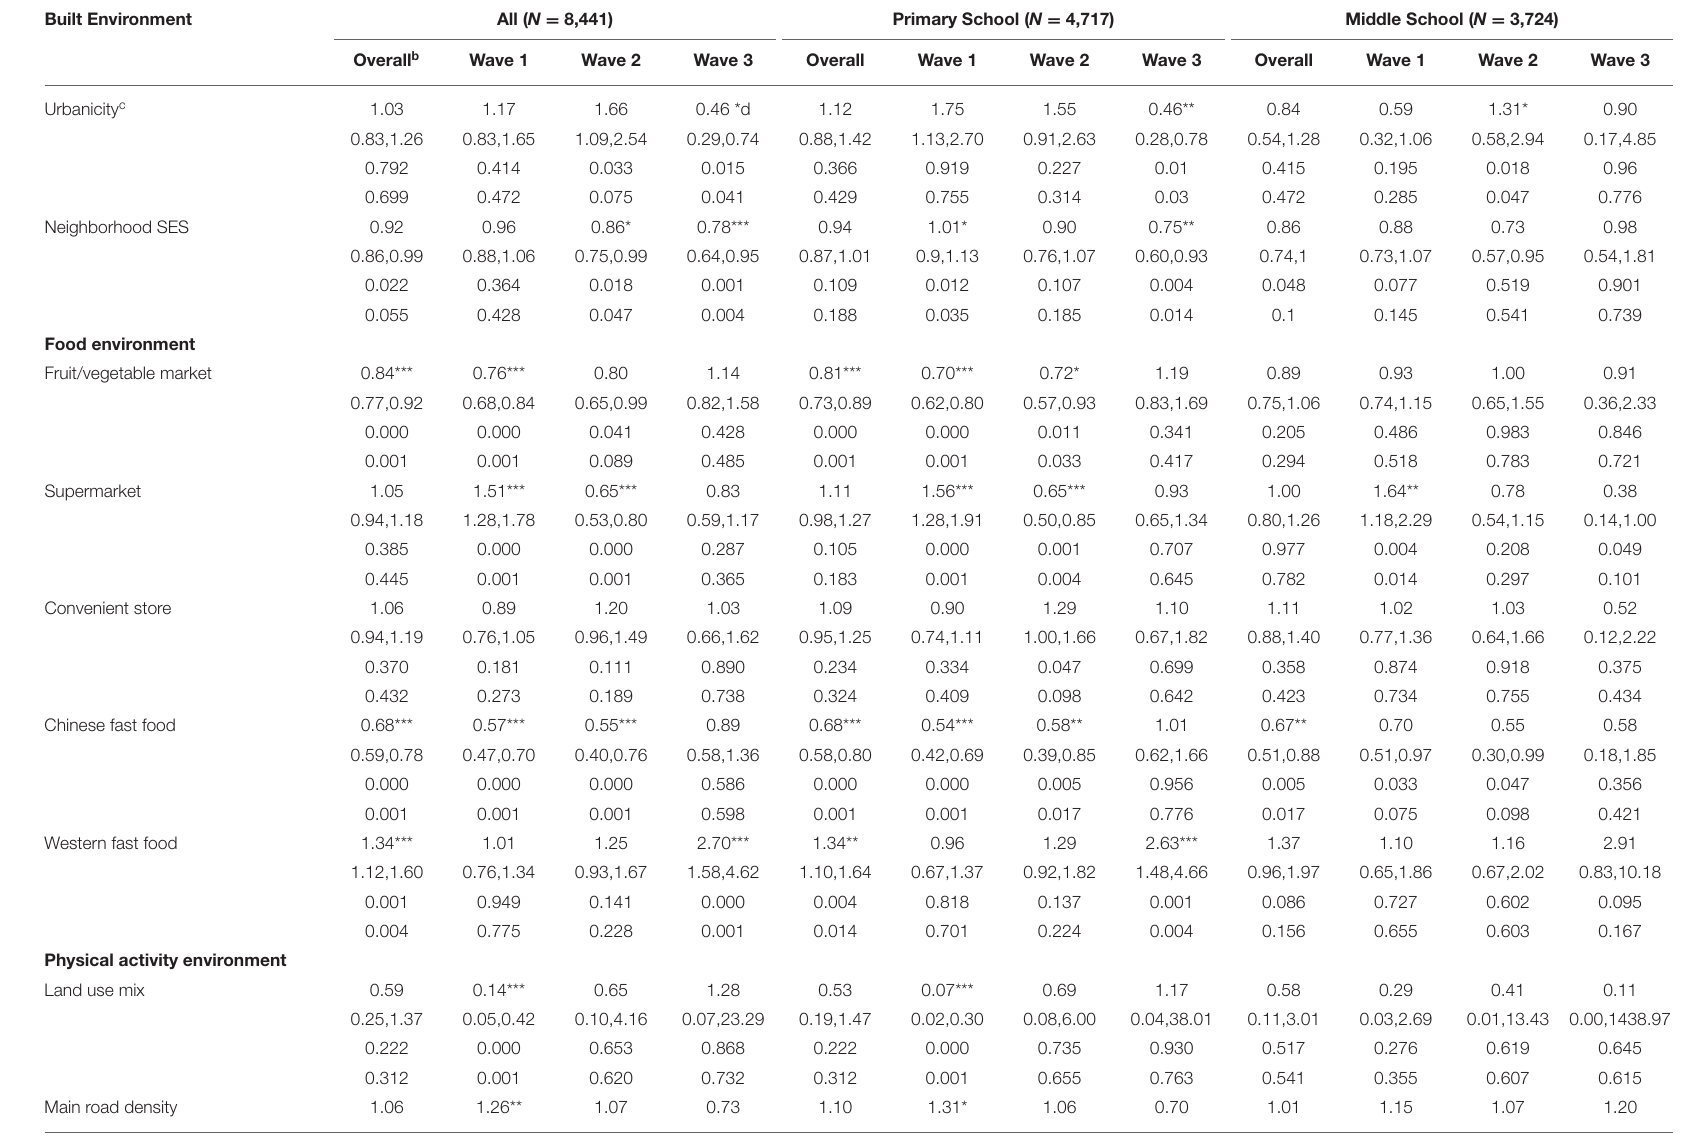
TABLE 3 | Associations of neighborhood built environments and childhood overweight and obesity 2011–2016 a